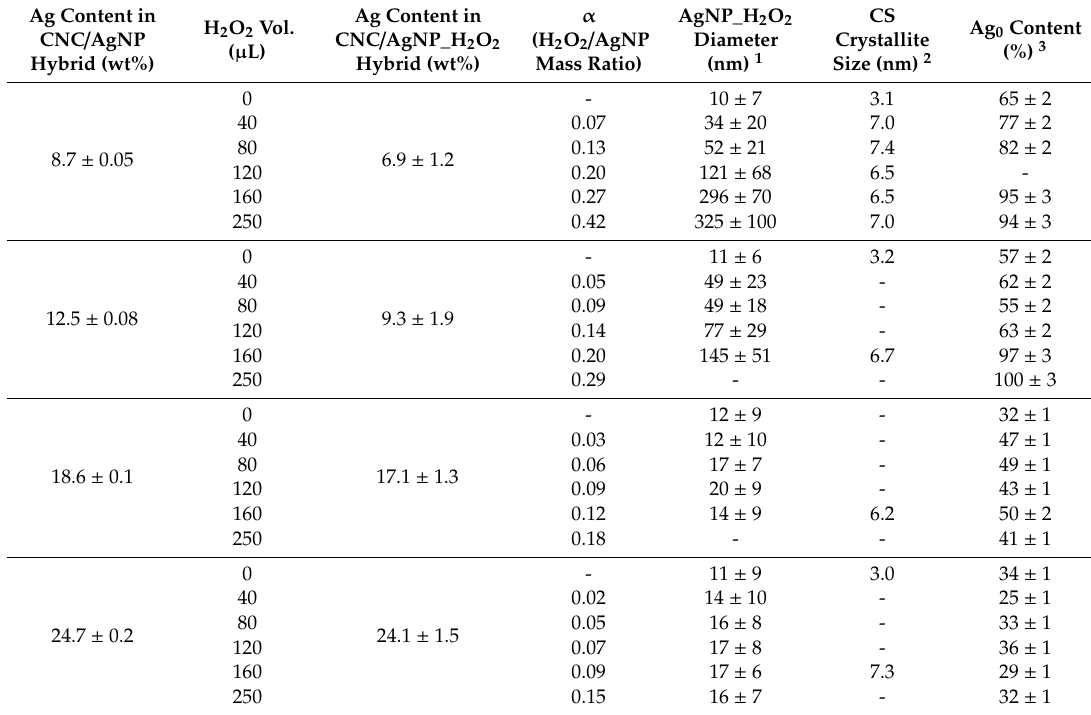
Table 1. Characteristics of CNC / AgNP hybrids at di ff erent AgNP contents with a H 2 O 2 redox post-treatment (CNC / AgNP_H 2 O 2